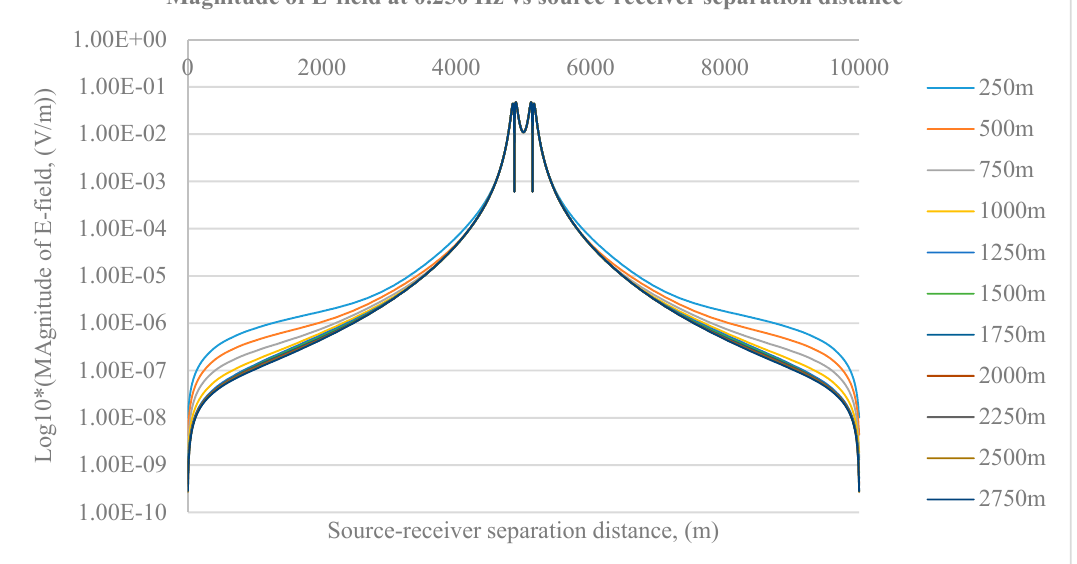
Figure 5. Log10 of magnitude of electric field at 0.25 Hz versus source–receiver separation distance (offset). Different hydrocarbon depths yield different EM responses. The offset is from 0 m (left of the SBL model) to 10,000 m (right of the SBL model).